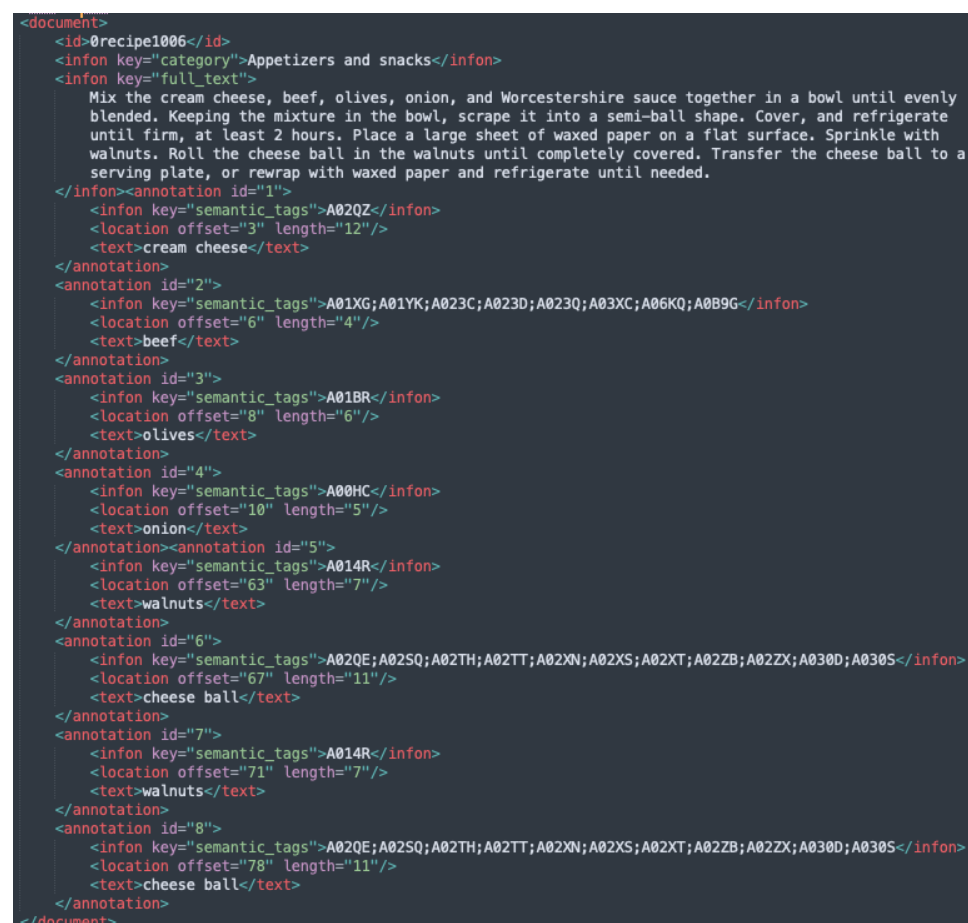
Figure 5. Example of an instance from FoodBase annotated with tags from the FoodEx2 classifica- tion system.